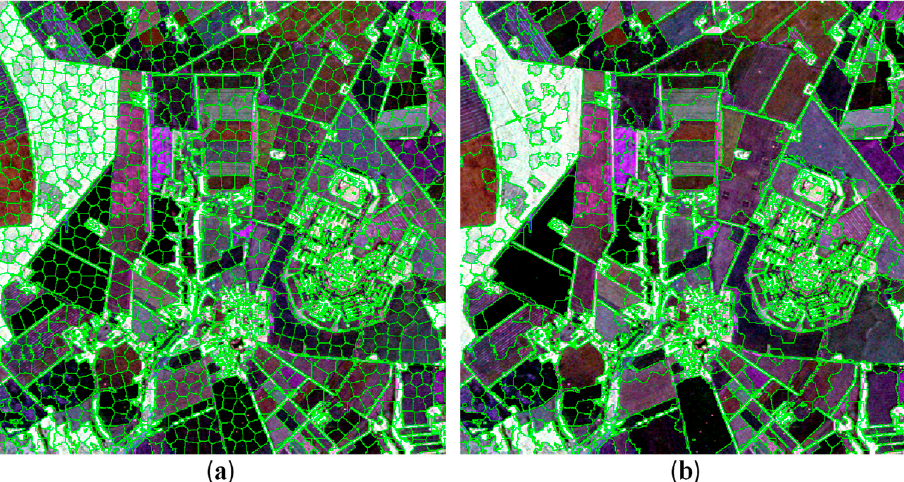
Figure 10. EMISAR data from Foulum, Denmark: ( a ) Pauli RGB image, where the green lines denote the boundaries of the initial superpixels; ( b ) The intermediate segmentation result after the WMS. Using the L-method, the optimal region number of the EMISAR data is obtained as 89.